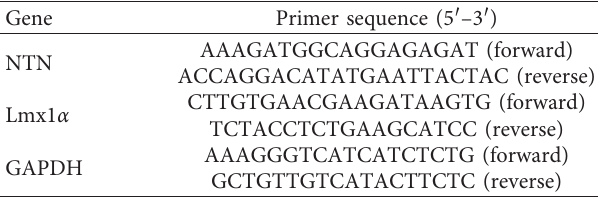
Table 1: Primer sequences of NTN and Lmx1 α . Gene Primer sequence (5 ′ –3 ′ )